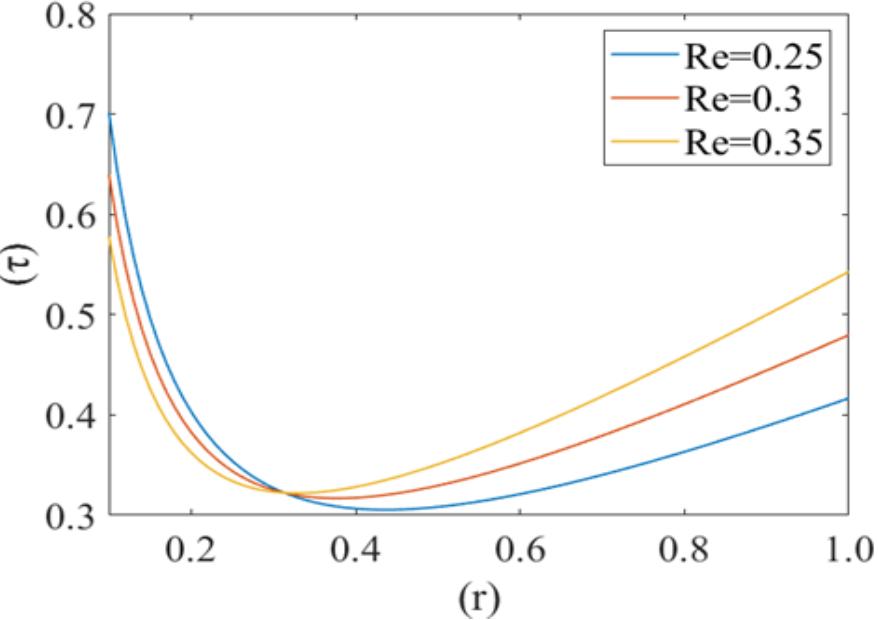
Figure 12. Variation of the drag force ( τ ) at the rim of the cell with respect to its radius ( r ) at different Reynolds numbers ( Re ) with P1 = 2, k =